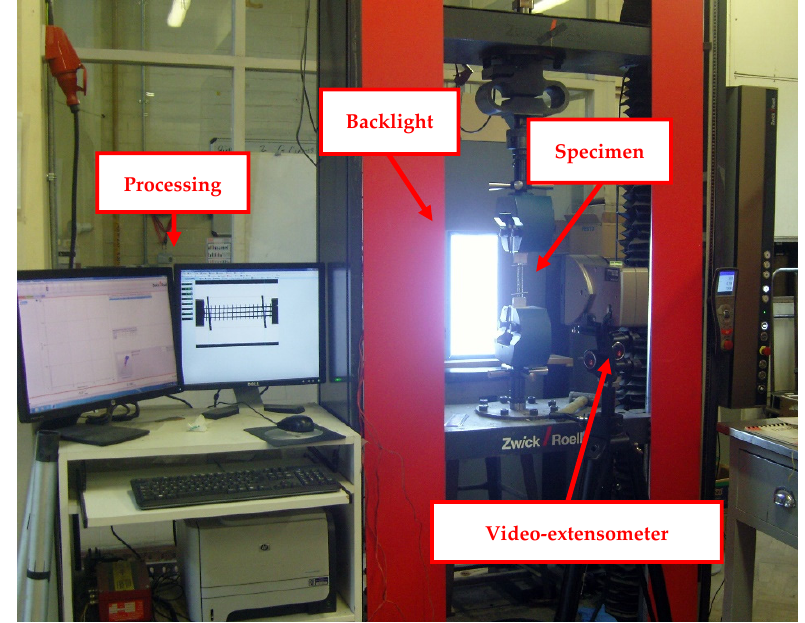
Figure 7. Test setup for the tensile tests on the basalt fabric.